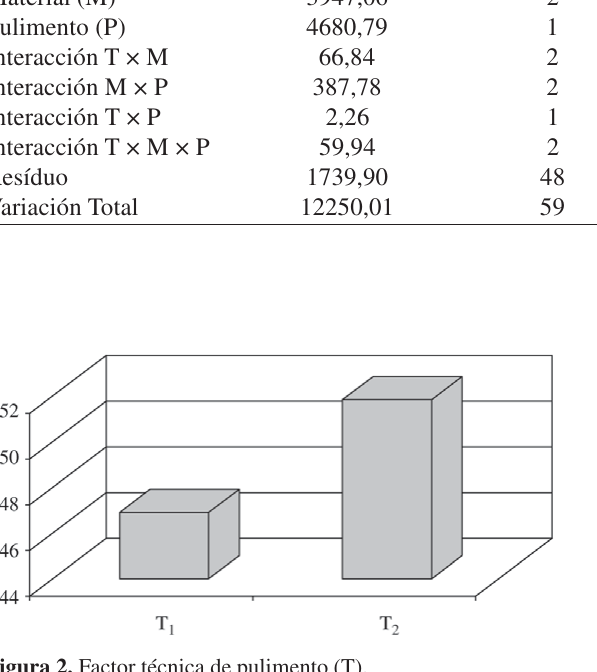
Figura 2. Factor técnica de pulimento (T).